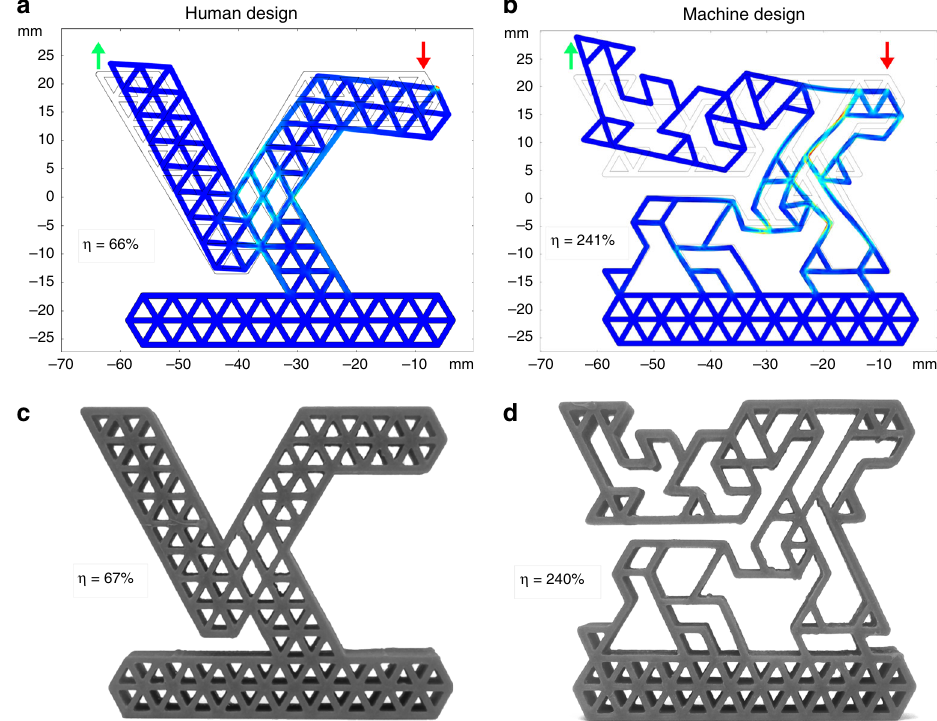
Fig. 2 Automatic design achieves ef fi cient anti-parallel movement. Comparison of ( a ) human-designed and ( b ) machine-designed structures for FEM simulated and ( c , d ) the corresponding 3D printed realizations. The color represents the Von Mises stress with the same colorbar as in Fig. 1c. Red (green) arrows indicate the direction of the desired input t inp (output t out ). Resulting ef fi ciencies are reported in each panel. For movement visualization see Supplementary Movie